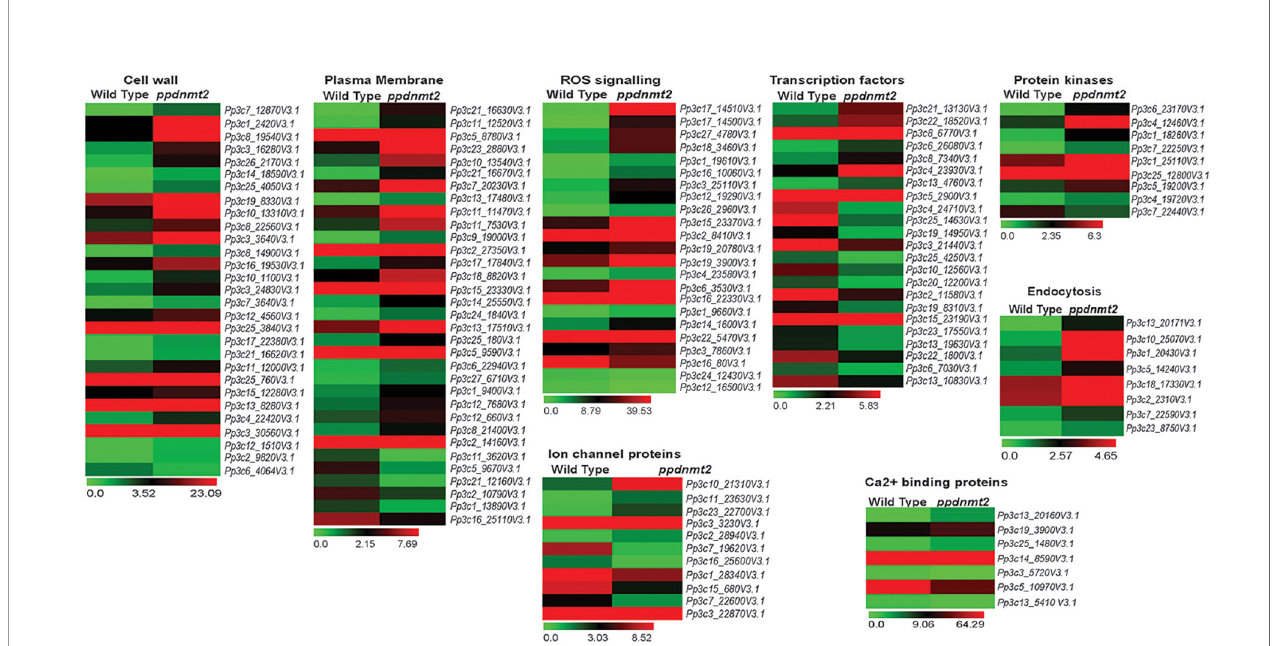
FIGURE 6 | Expression patterns of genes encoding proteins involved in stress sensing at cell wall and plasma membrane, ion homeostasis regulation, ROS signaling, cytoskeletal dynamics, and those encoding transcription factors. Average FPKM values of genes in wild type and ppdnmt2 are presented by cluster display (heat map) with color scale representing range of expression values shown at the bottom of each heat